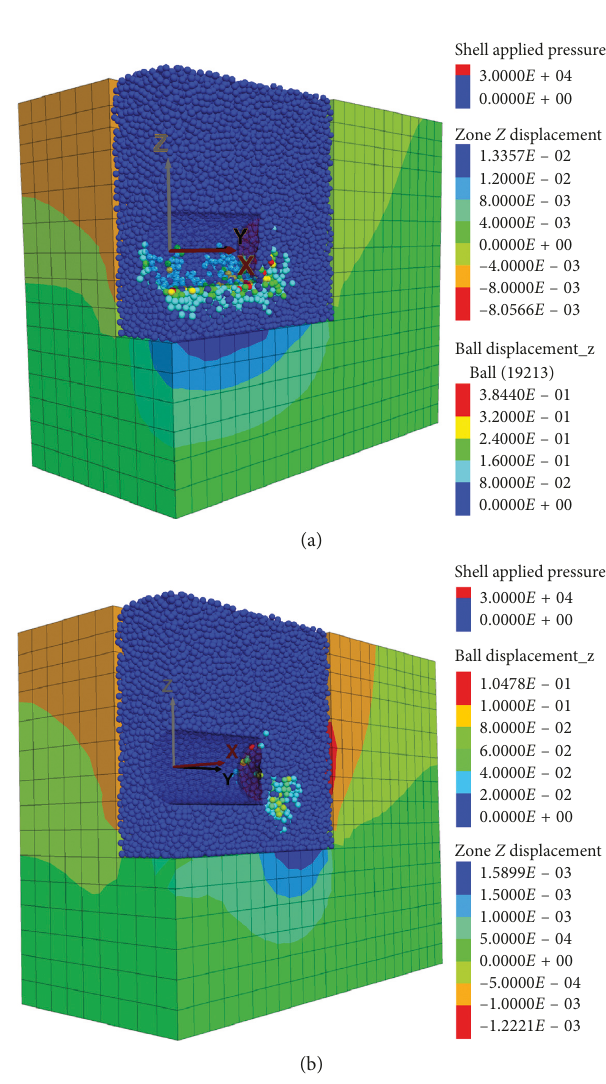
Figure 12: Excavation surface displacement cloud under support force of 30kPa. (a) Excavation-support. (b)